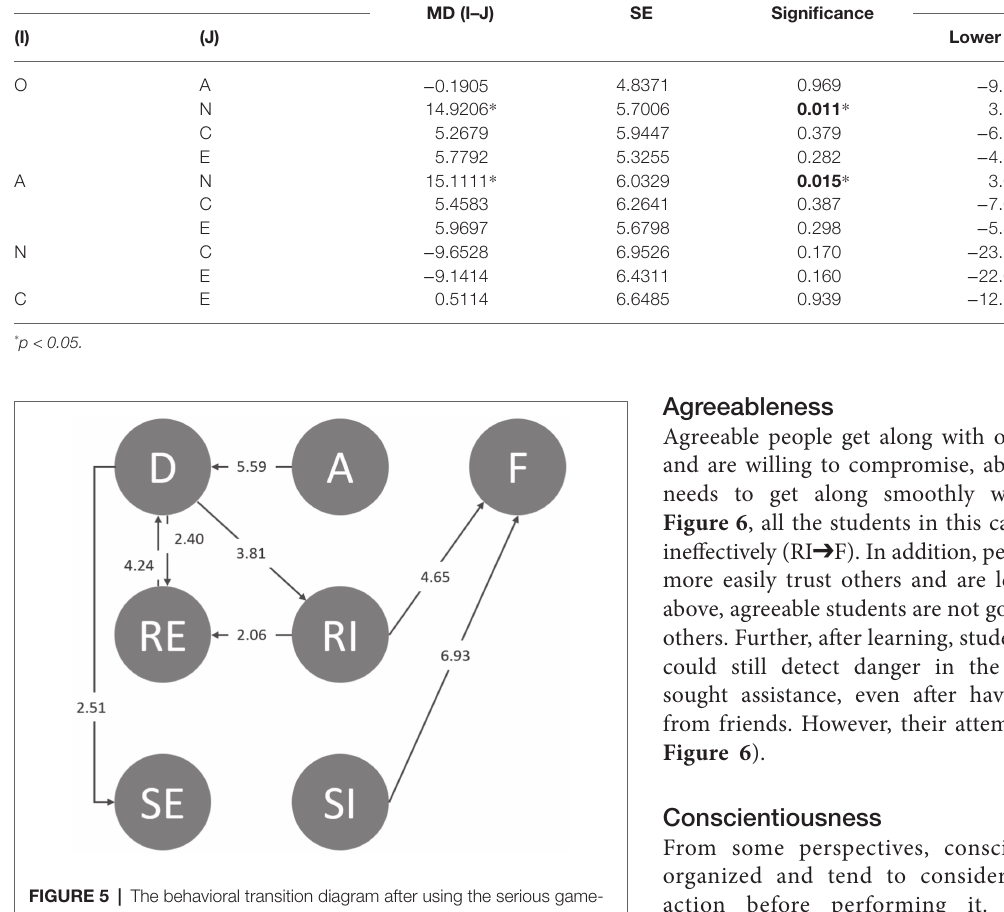
TABLE 4 | ANOVA of learning effectiveness among different learning strategies and personality traits. Trait